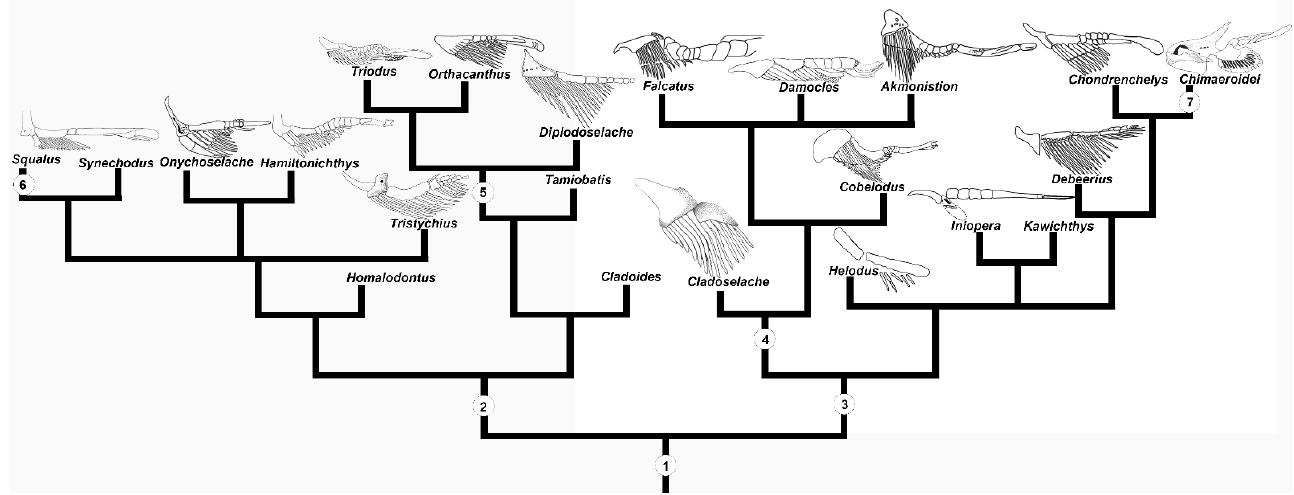
Figure 9. Chondrichthyan phylogeny (after [8]) with reconstructions of the pelvic skeletons. 1- Chondrichthyes 2- Elasmobranchii 3- Holocephali 4- Symmoriiformes 5- Xenacanthiforms 6- Crown group Elasmobranchii 7- Crown group Holocephali. Illustrations redrawn from [1,2,49–62].